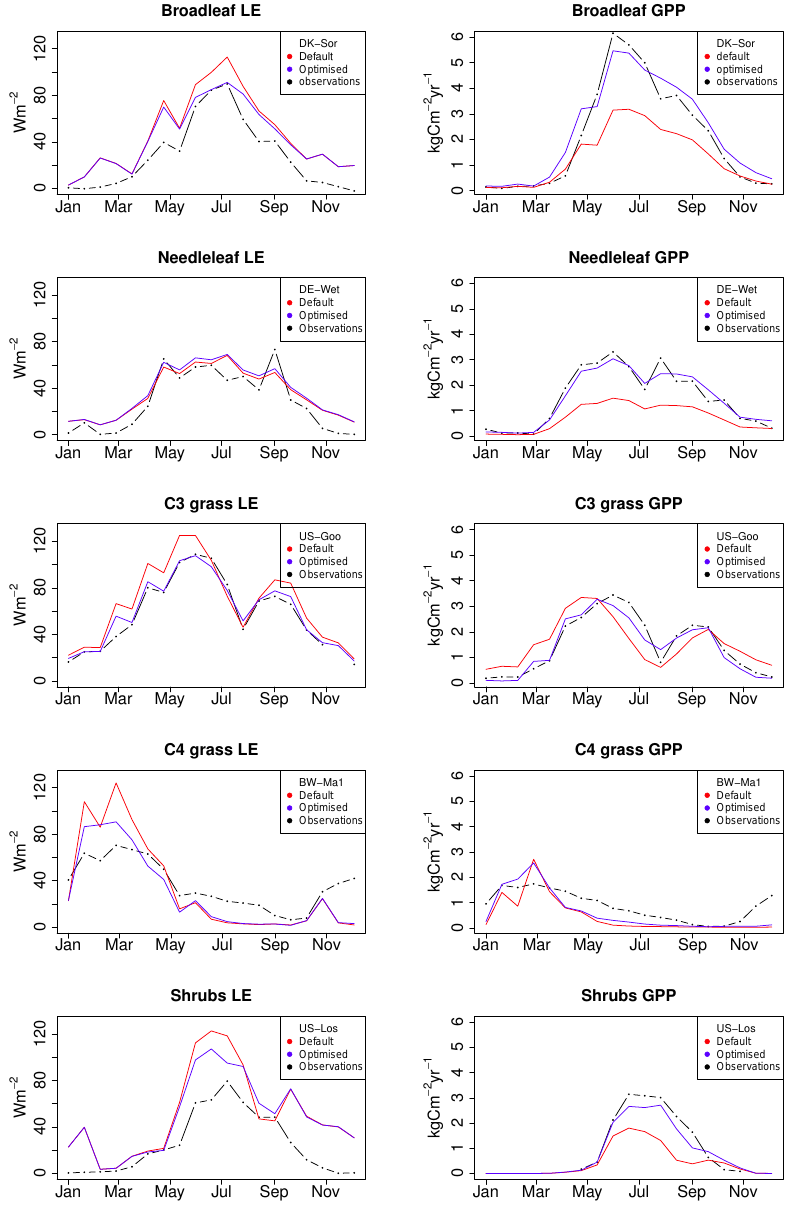
2 Figure 2. Time-series plots for illustrative site-specific evaluations showing LE (left) and GPP (right) for each of the different PFTs. Obser- vations (black) are compared to JULES runs using default parameters (red) and site-specific optimal parameters